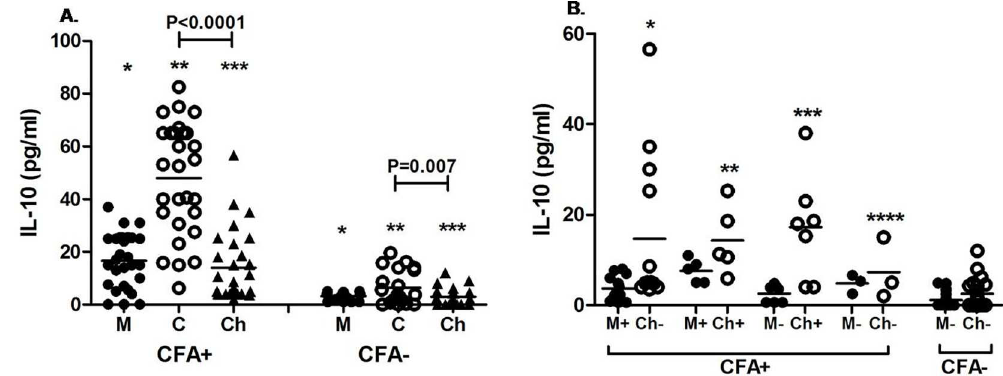
Fig 4. Plasma level of IL-10 in CFA +ve and CFA-ve mothers and their children at the time of delivery and during follow-up. Each dot representsan individual’sIL-10 level and lines representsthe mean values. A . IL-10 level of CFA+ve (n = 28) and CFA-ve (n = 21) mother (M) and their cord (C) at the time of deliveryand in children (Ch) duringfollow up. CFA +: mothers CFA +ve at the time of enrolment. CFA-: Mothers who were CFA-ve at the time of enrolment. * p < 0.0001, ** p < 0.0001, *** p < 0.0001. B. IL-10 levels in mother and their childrenat the time of follow up. M+Ch+: mother and childrenCFA+ve (n = 5), M+Ch-: mother CFA+ and childrenCFA-ve (n = 13), M-Ch +: mother CFA-ve and children CFA+ve (n = 7), M-Ch-: mother and childrenare CFA-ve (n = 3). M-Ch-: children born from uninfected(CFA–ve) mother (n = 20). * p= 0.001, ** p = 0.002, *** p = 0.002, **** p= 0.03 as compared to children(M-Ch-) of CFA–ve